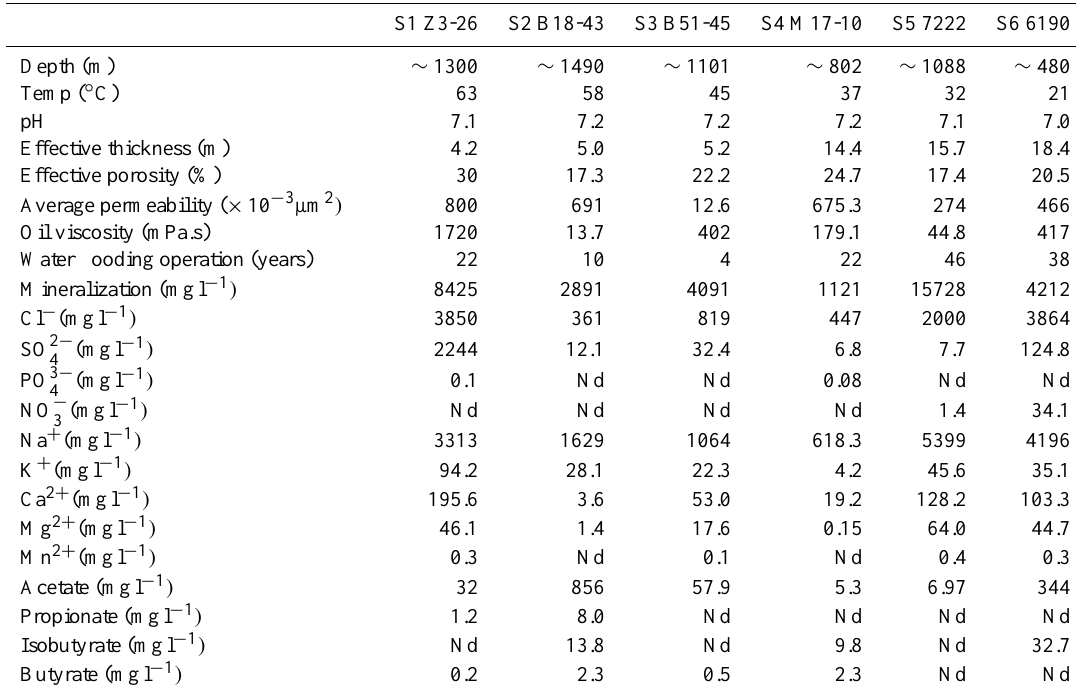
Table 1. Characterization of the water samples collected from different petroleum reservoirs. (Nd=not